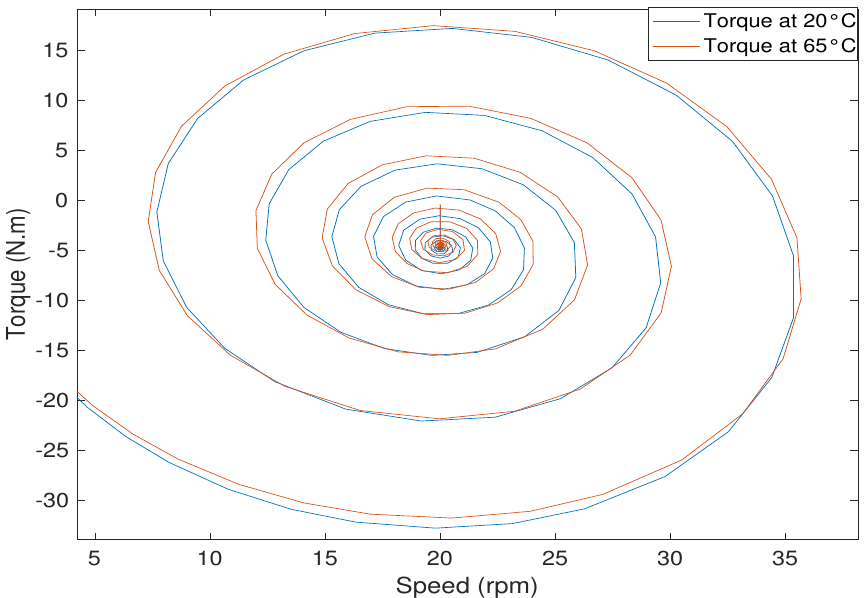
Figure 3. Change of torque with respect to speed at temperature 20 ◦ C and 65 ◦ C.